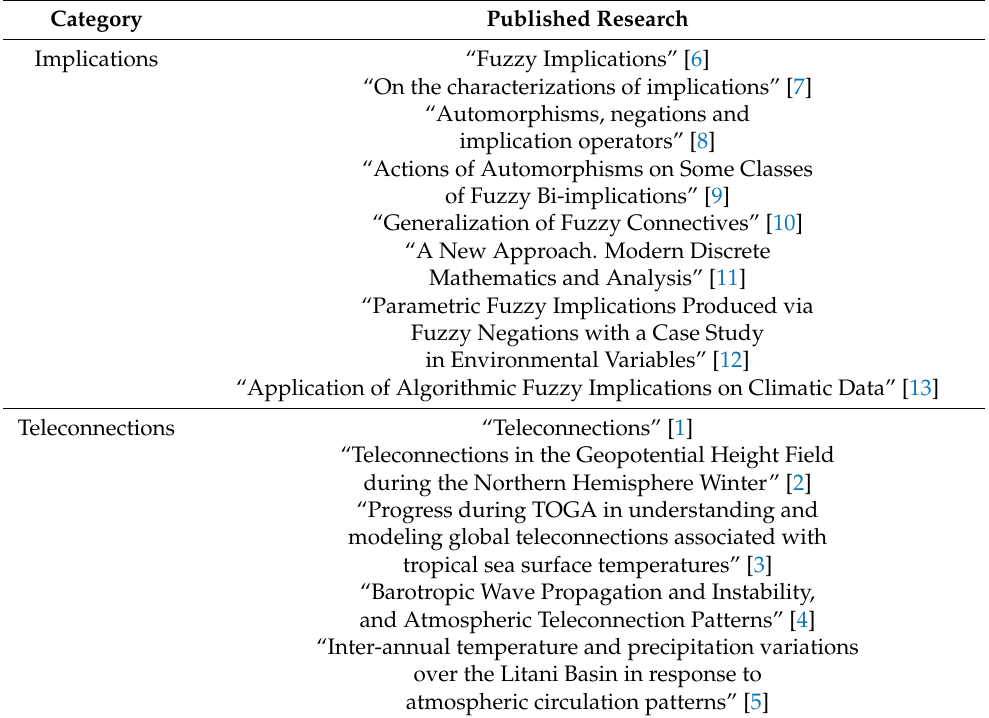
Table 1. Published